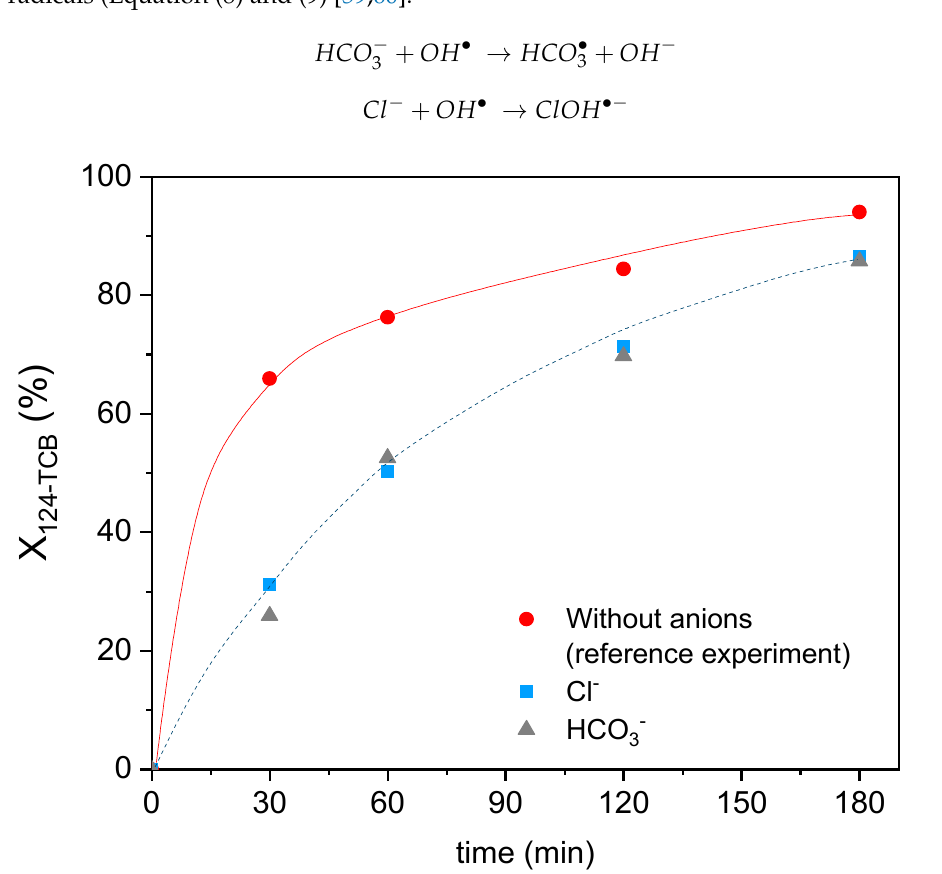
Figure 5. 124-TCB conversion vs time for the three systems analyzed at optimum model-predicted conditions. Experimental conditions: Fe = 7.10 mg L − 1 , H 2 O 2 = 290 mg L − 1 , 124-TCB = 28 mg L − 1 , Cl − = 600 mg L − 1 , HCO 3 − = 600 mg L − 1 , and High rad intensity. Experimental data as symbols. Trends as lines.